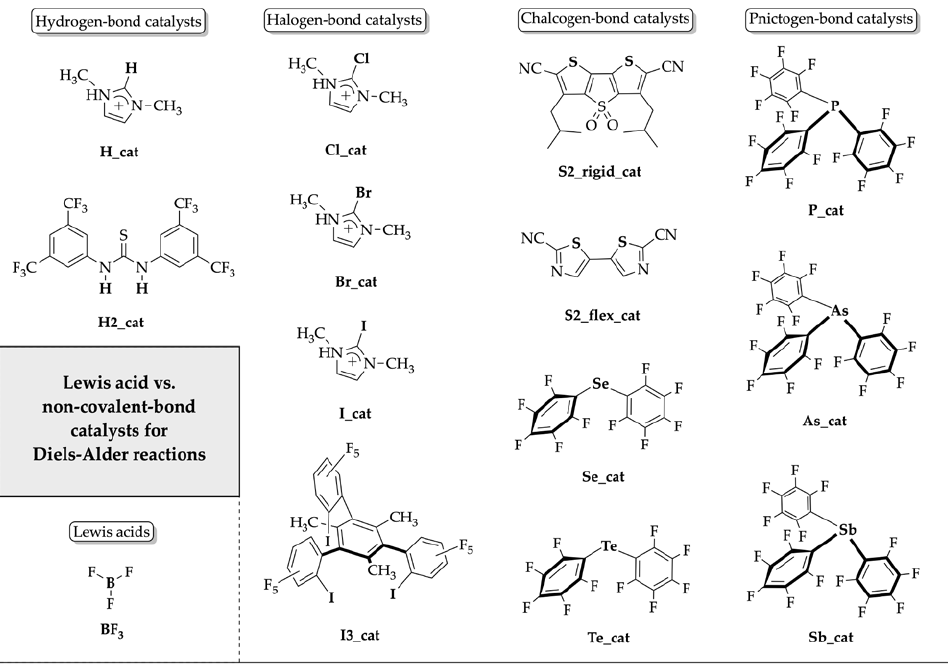
Figure 1. Variety of Lewis acid and non-covalent Lewis acid-like catalysts considered in this study.